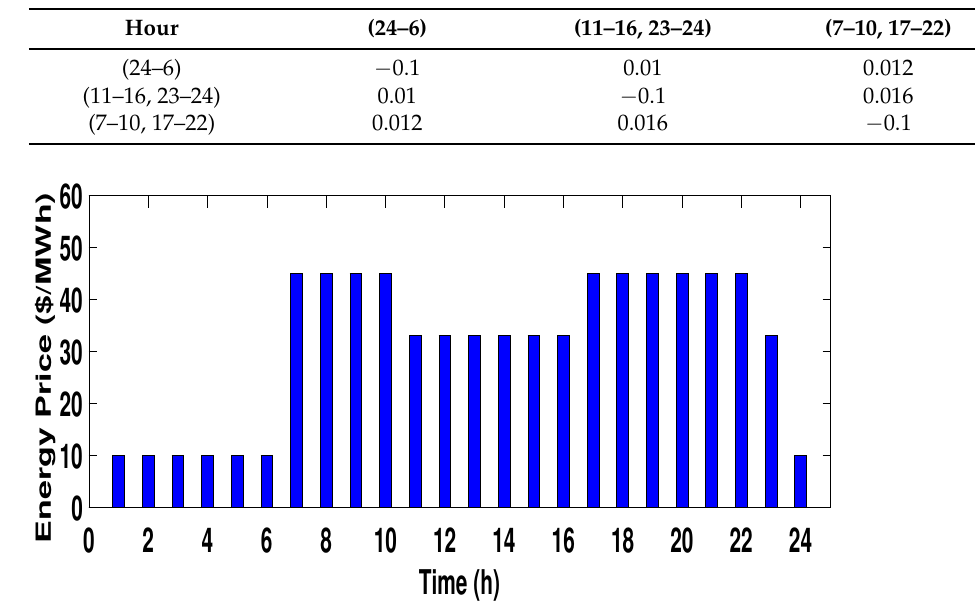
Figure 10. Energy prices for the proposed DR